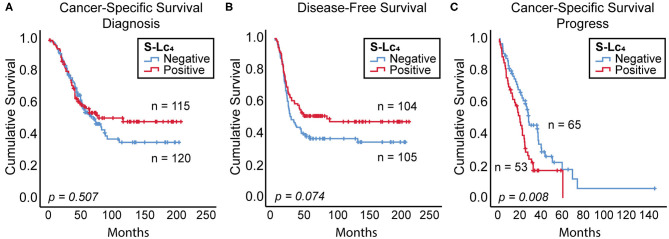
Prognostic value of S-Lc4 in ovarian carcinoma. Kaplan-Meier curve demonstrating the association between S-Lc4 expression and prognosis in terms of (A) cancer-specific survival (from time of diagnosis), n = 235, (B) Disease-free survival, n = 209, and (C) Cancer-specific survival (from time of progress), n = 118. The p-values indicated in the figure are determined using the log-rank test. Number of patients per group are indicated in the figure.